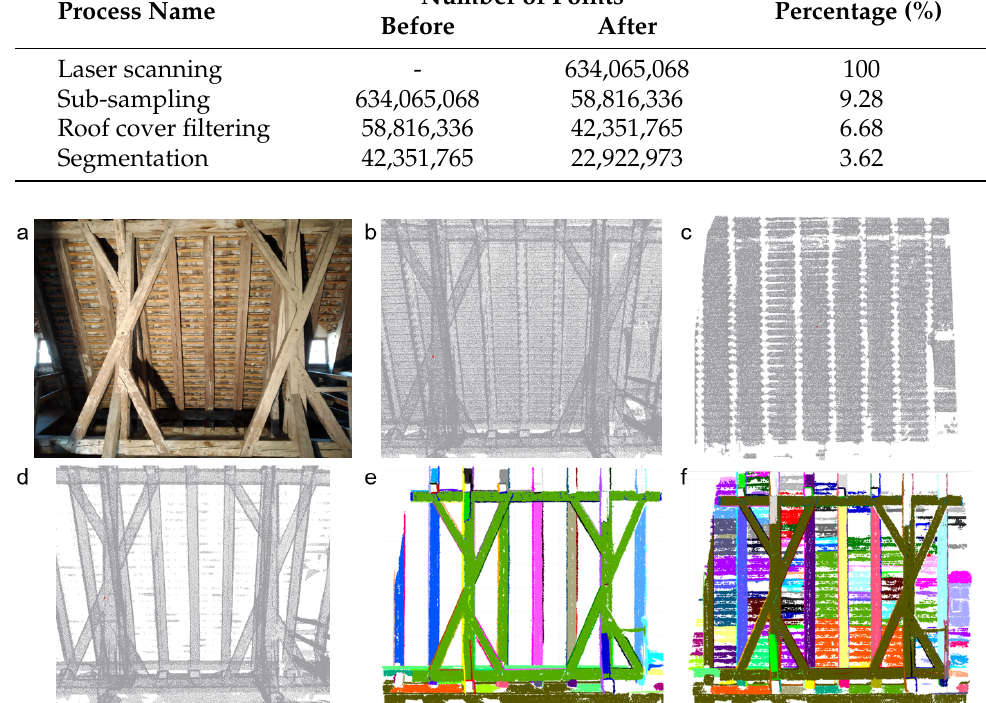
Figure 9. Image of a roof cover part from inside ( a ), point cloud data of the region ( b ), filtered roof cover ( c ), interior points after roof cover filtering ( d ), segmentation result of roof interior after roof cover filtered ( e ) and segmentation result of the point cloud including roof cover ( f